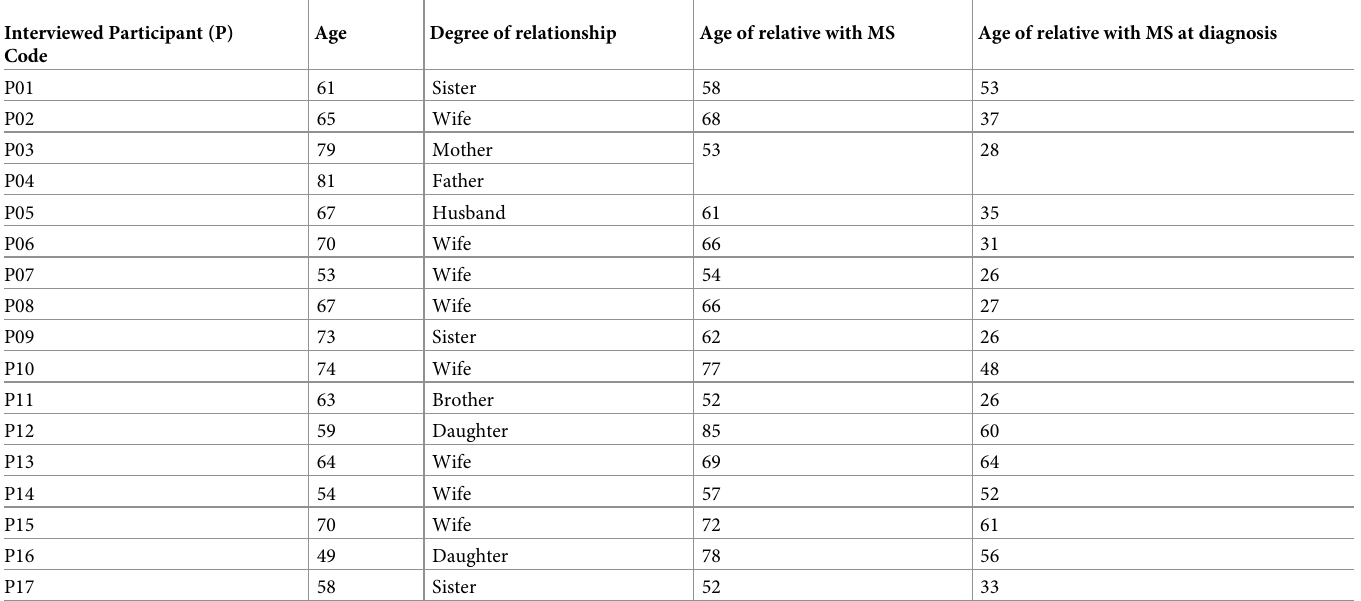
Table 1. Characteristics of people